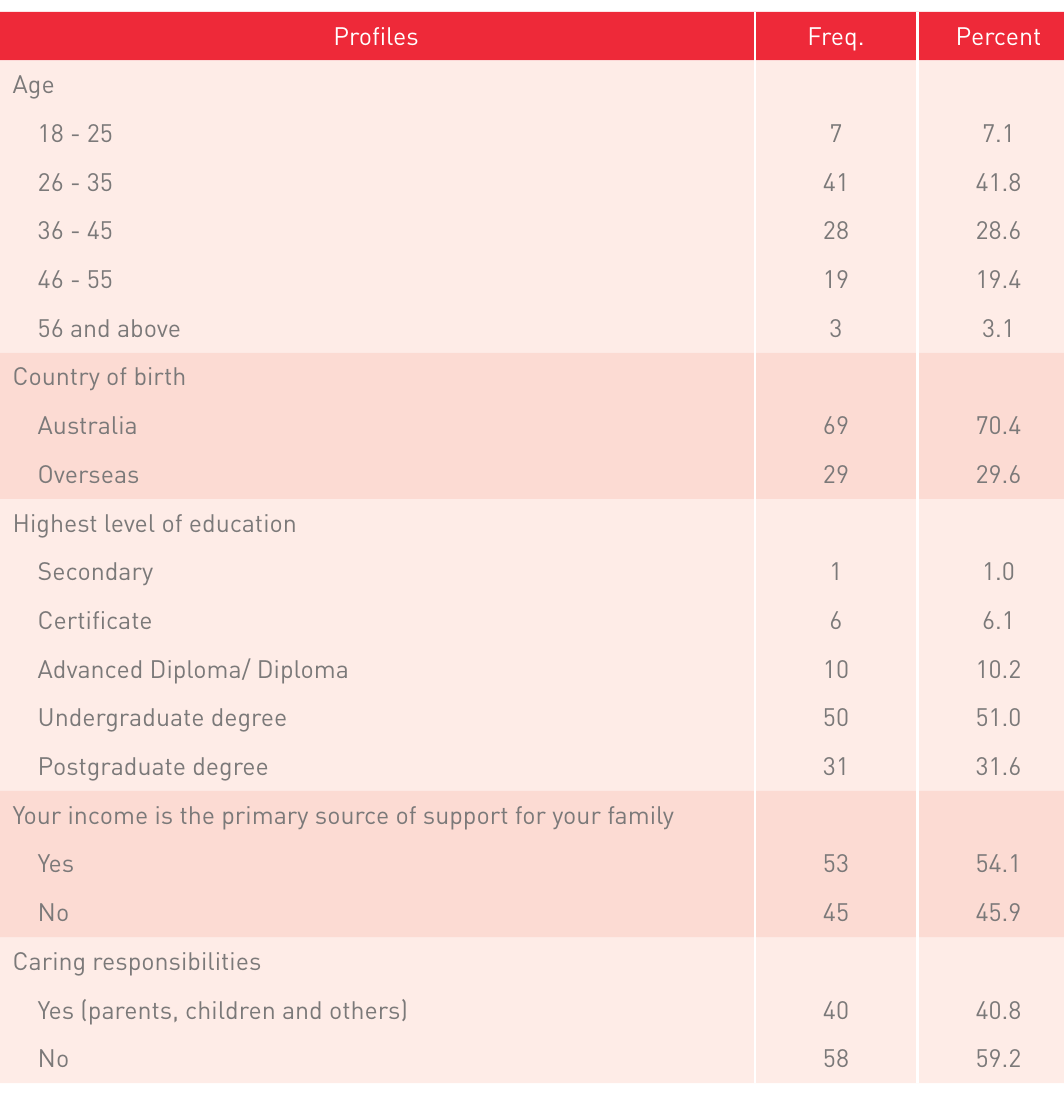
The demographic profiles of the respondents Profiles